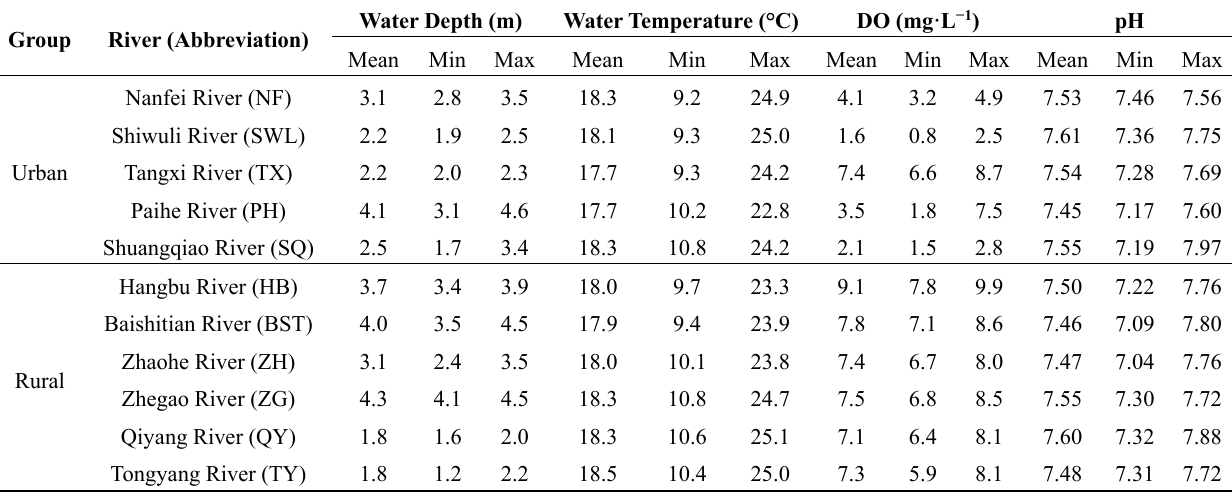
Table 1. Physico-chemical parameters of 11 rivers flowing into Lake Chaohu at the time of sampling. Water Depth Group River (Abbreviation)